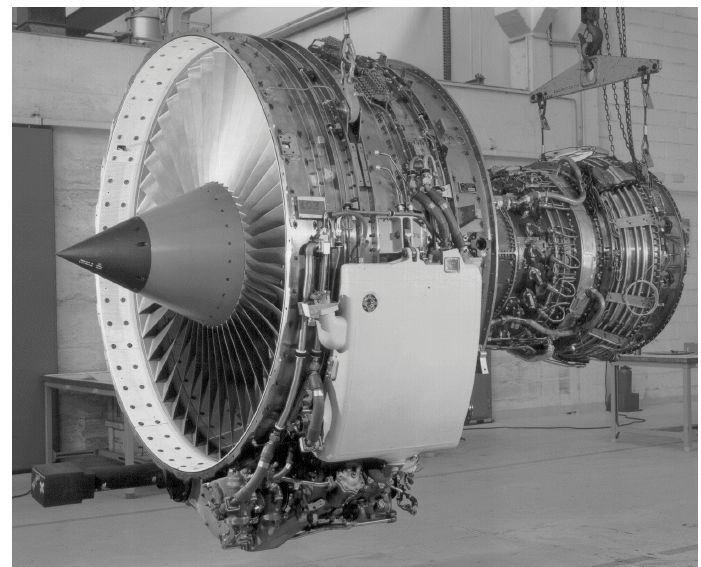
Fig. 10. CFM 56 jet engine – Courtesy SNECMA.